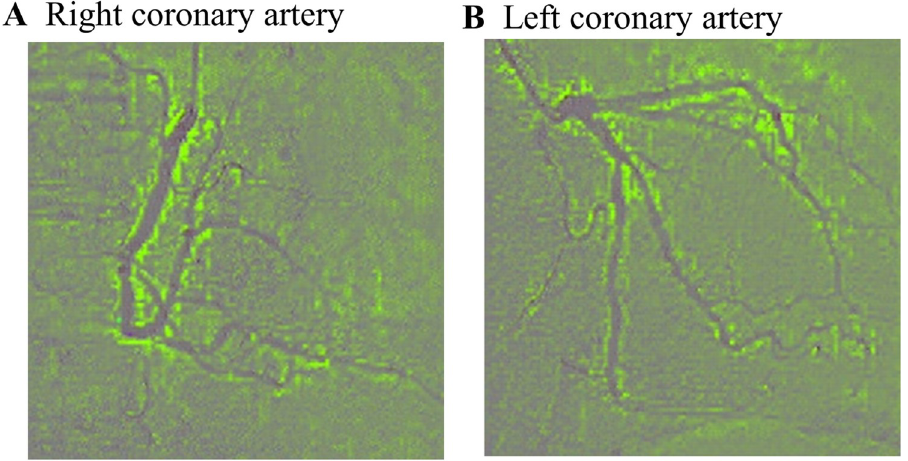
Fig 4. Representative Grad-CAM images (Efficientnet-B7, using the test dataset). Green areas represent the areas upon which the model focused. A, right coronary artery; B, left coronary